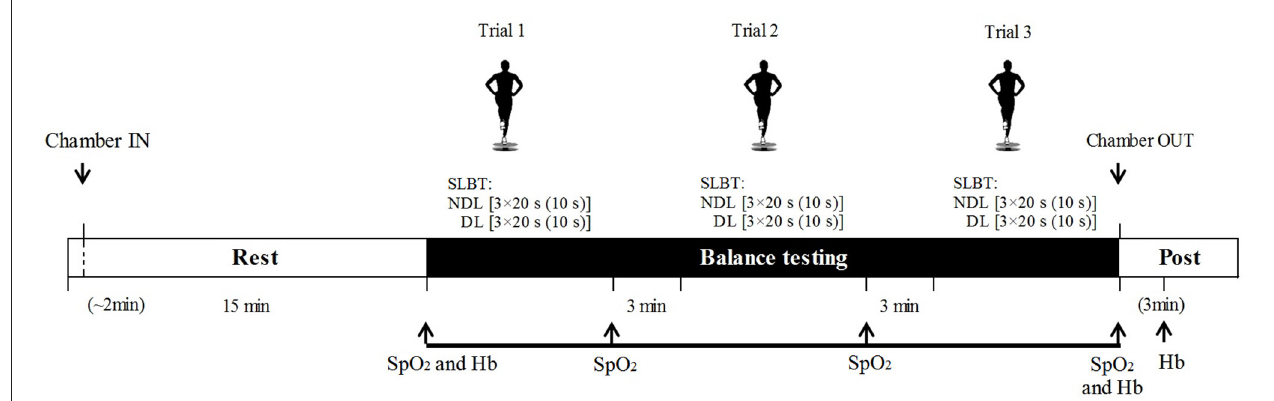
FIGURE 1 | Testing protocol indicating single-leg balance tests, oxygen saturation (SpO 2 ), and heart rate (HR) assessment in both conditions: normobaric hypoxia (HYP) and normoxia (NOR). Hemoglobin (Hb) was assessed only in HYP. For balance trials, number of repetitions, repetition duration, and resting periods are represented as follows: leg [repetitions × repetition duration (inter-set recovery)]. DL, dominant leg; NDL, non-dominant leg.